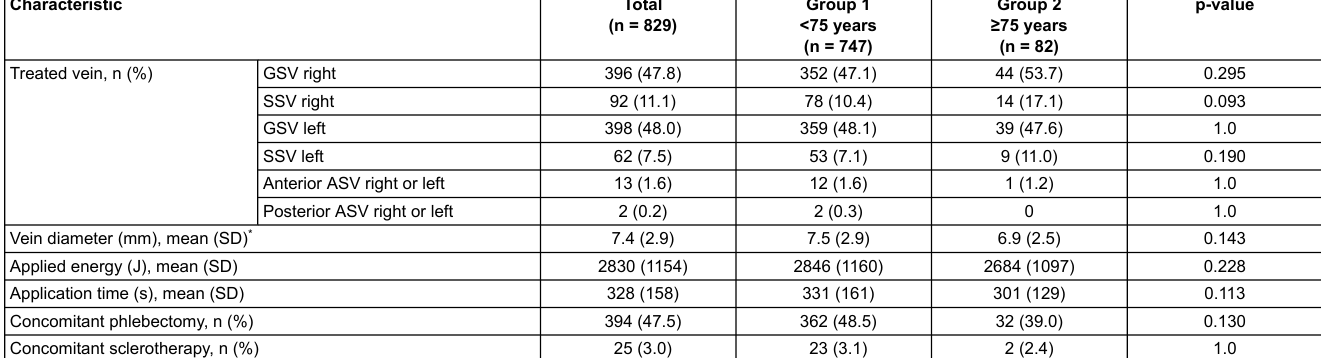
Table 2: Lesion characteristics and procedural data.